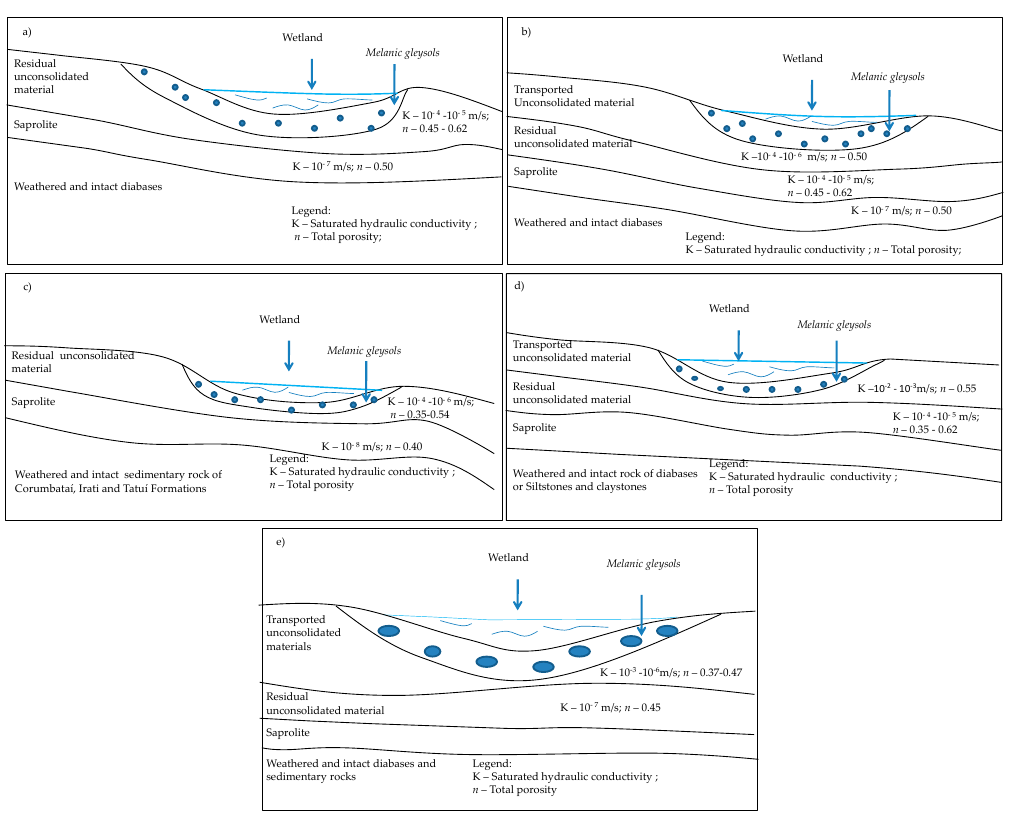
Figure 6. Wetlands and geological materials: ( a ) typical cross section of wetlands associated with diabase and residual unconsolidated material; ( b ) typical cross section of wetlands associated with transported unconsolidated material composed of clay colluvium overlying the diabase; ( c ) typical cross section of wetlands associated with residual unconsolidated materials from the Corumbataí, Irati, and Tatuí Formations; ( d ) typical cross section of wetlands associated with transported unconsolidated material consisting of sandy colluvium deposited on the residual materials; ( e ) typical cross section wetlands associated with unconsolidated materials in alluvial deposits.